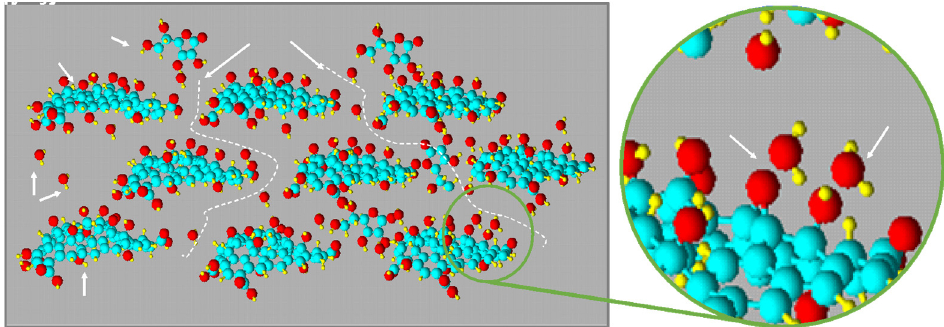
Figure 5. Representation of swollen GO and the diffusion pathway of a L-aa aqueous solution.